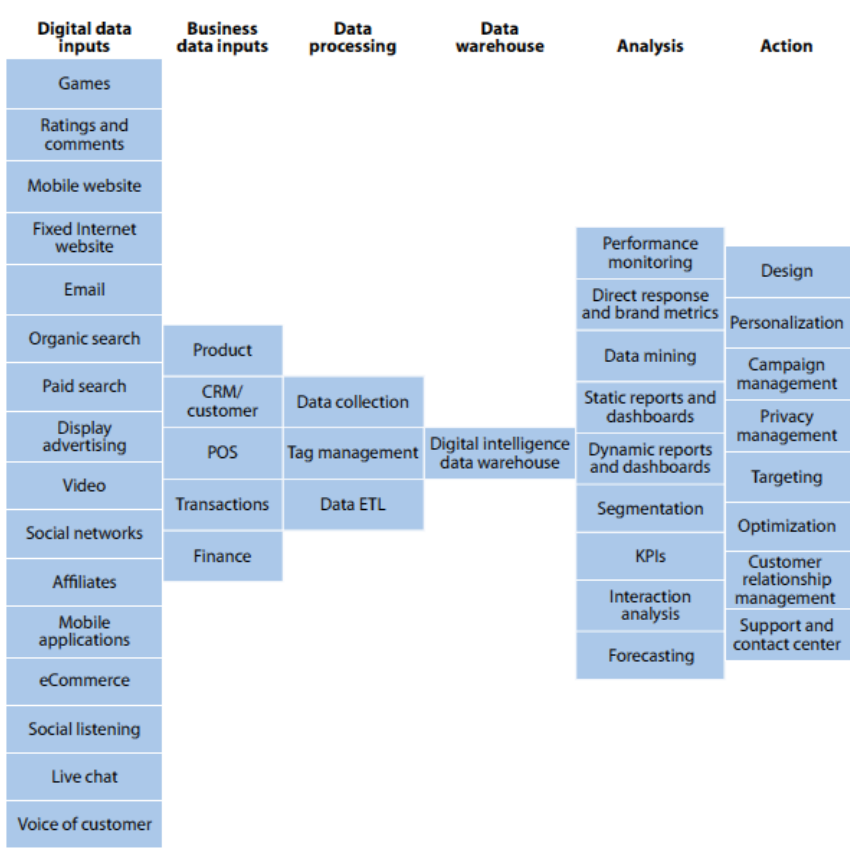
Figure 2. Stanhope’s “Digital Intelligence